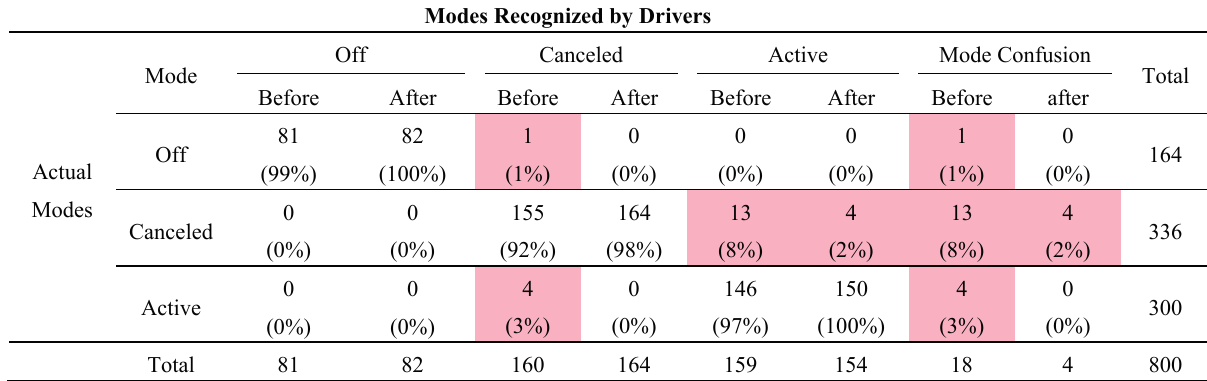
Table 10. Mode confusion rates before and after glancing at the three-mode interface in the